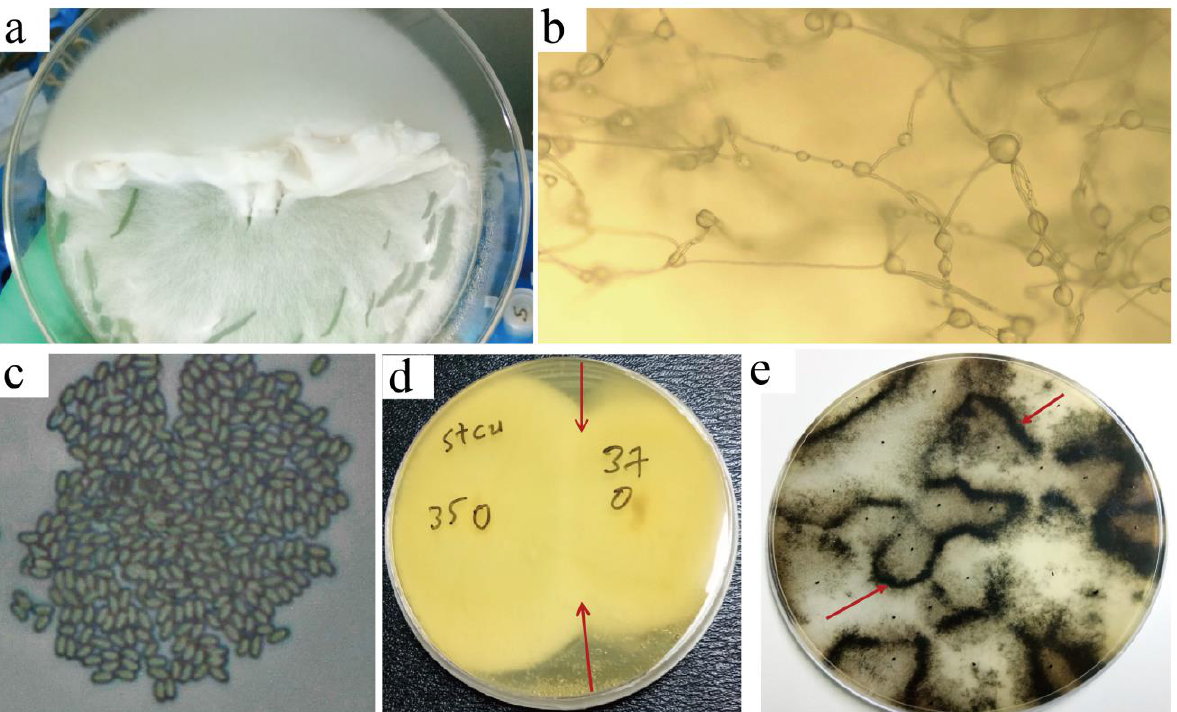
Figure 6. Mating type compatibility test and effective sporulation of different Ascosphaera apis ( A. apis ) strain. ( a ) Sporeless fluffy mycelial growth structure of A. apis mutant colonies. ( b ) Matured and remarkably small sized A. apis mutants spore cysts. ( c ) Effective matured A. apis wild strain asco-spores. ( d ) Mating type compatibility and asco-spore development test among different Cas9 edited StcU-2 mutant A. apis colonies. Arrows show line of spore cyst barrage for StcU-2 mutants, and wild strain A. apis after mating. Numbers denote individual mutants. Black dots denote initial mycelial inoculation sites. ( e ) Effective mating and sporulation of wild strain. Arrows show line of spore-cyst barrage.